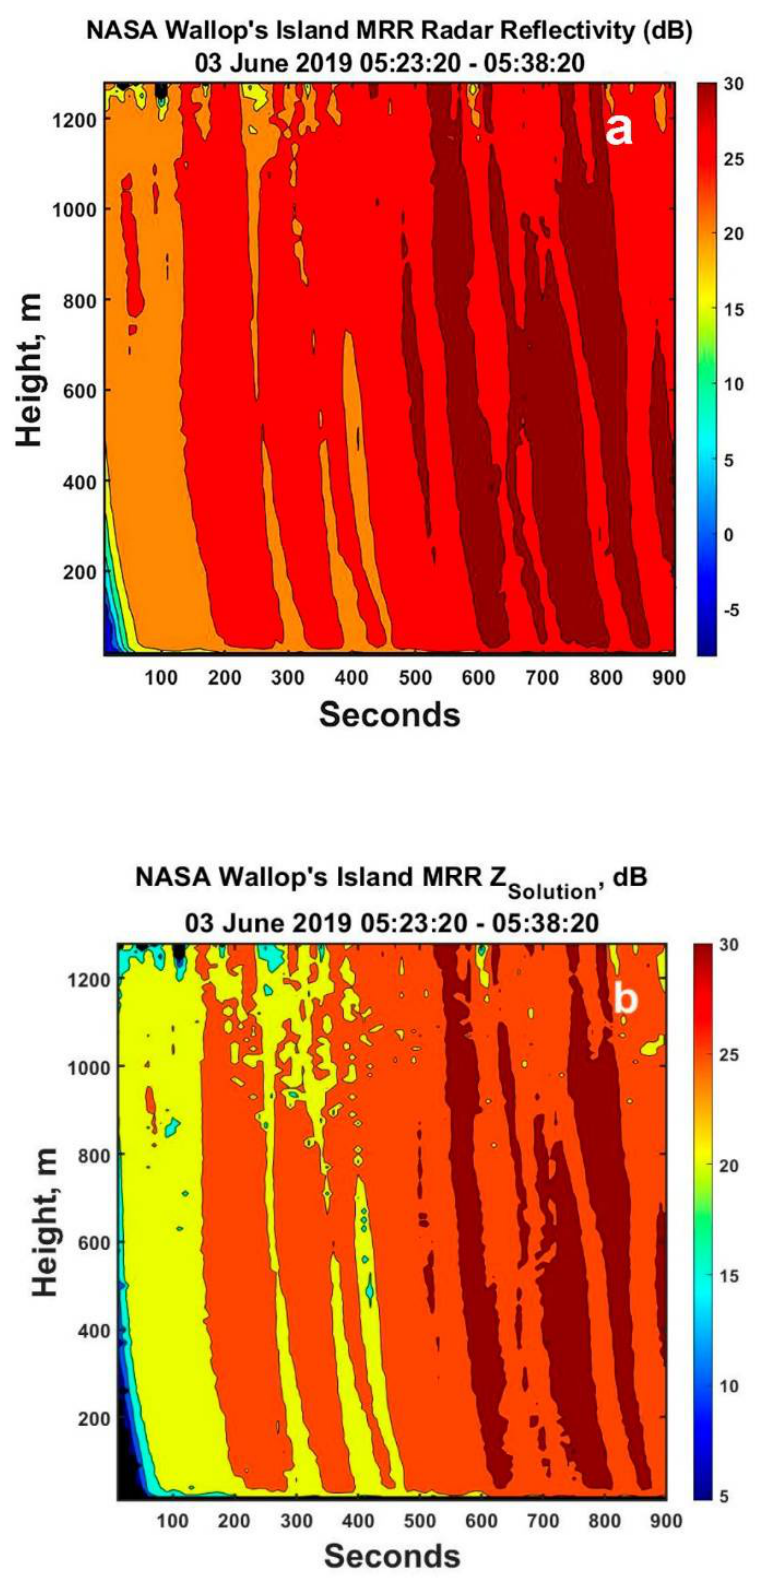
Figure 9. ( a ) The time–height plot of the measured MRR measured radar reflectivity for this time period and ( b ) the calculated solution values ( Z Solution ). Note the vertical structure in Z as reflected by the rainfall rates in Figure 7. The added jitter in ( b ) is due to the quantization of the velocity bins. The black denotes no power observed.